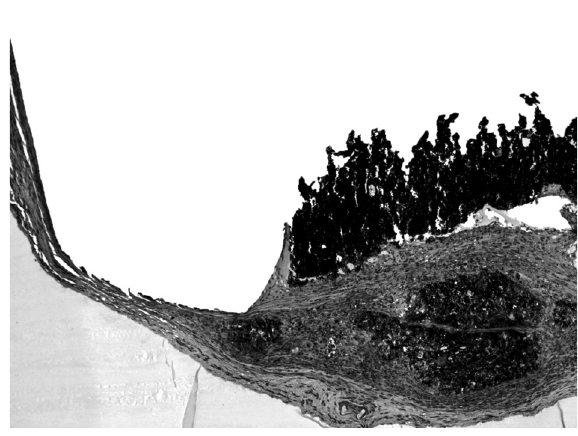
Figure 4. Inflammatory response in diabetic Sealapex group at day 30: moderate inflammatory cell infiltration (hematoxylin-eosin, 10X).